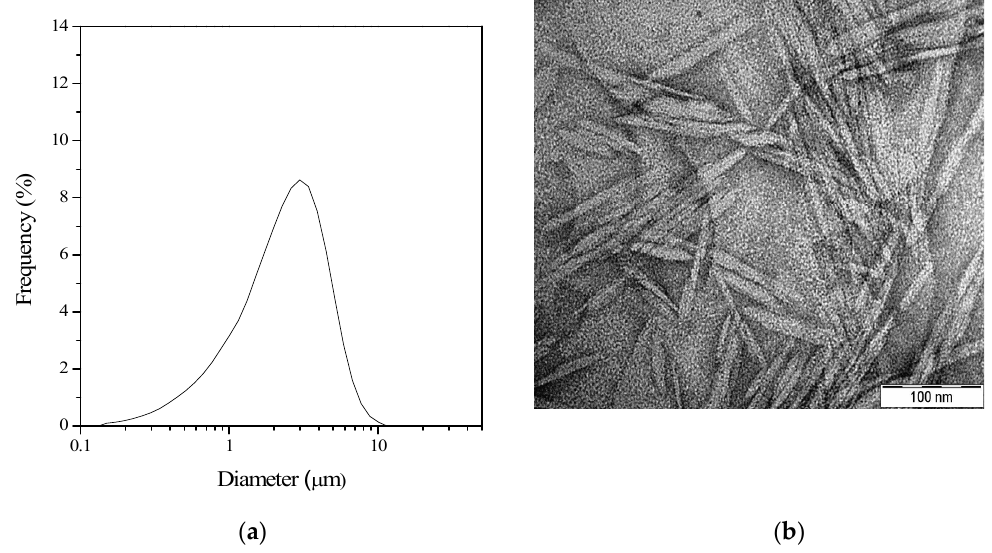
Figure 1. ( a ) Particle size distribution of CNC in an aqueous suspension determined by laser diffrac- tion particle size analysis; ( b ) TEM micrographs (18,000×) of CNC particles in aqueous suspension.